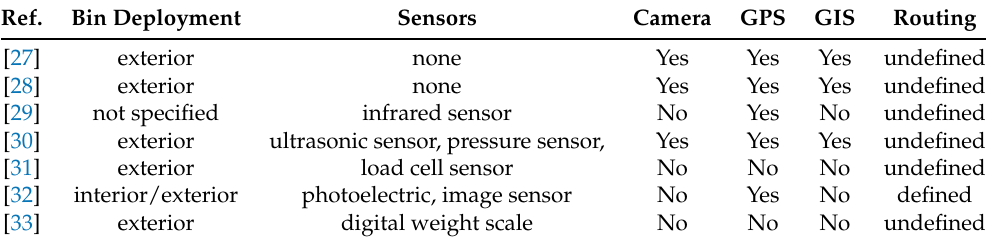
Table 1. Summary of RFID-enabled Trash Bin Level Monitoring Systems.